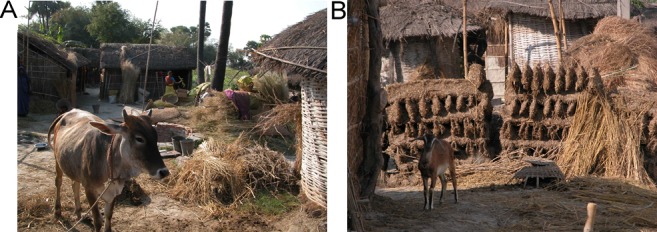
Endemic area for VL in India (Muzaffarpur).(A) People live in close contact with animals that may attract sand flies. (B) Typical houses with walls made of mud. VL, visceral leishmaniasis.